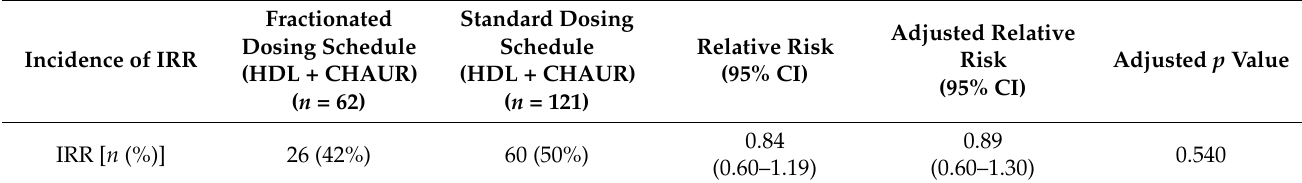
Table 3. Incidence of infusion-related reactions according to infusion protocol.